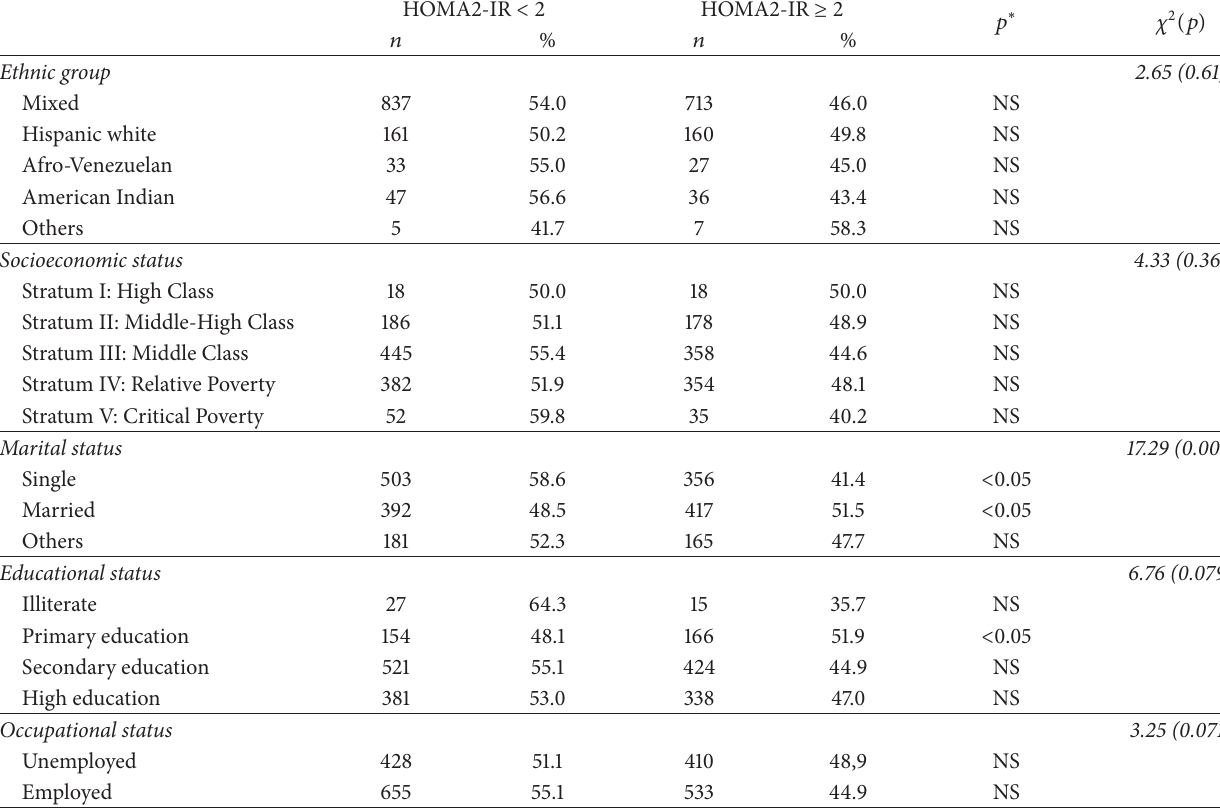
Table 4: Prevalence of insulin resistance in the general population by sociodemographic variables (Maracaibo, Venezuela,